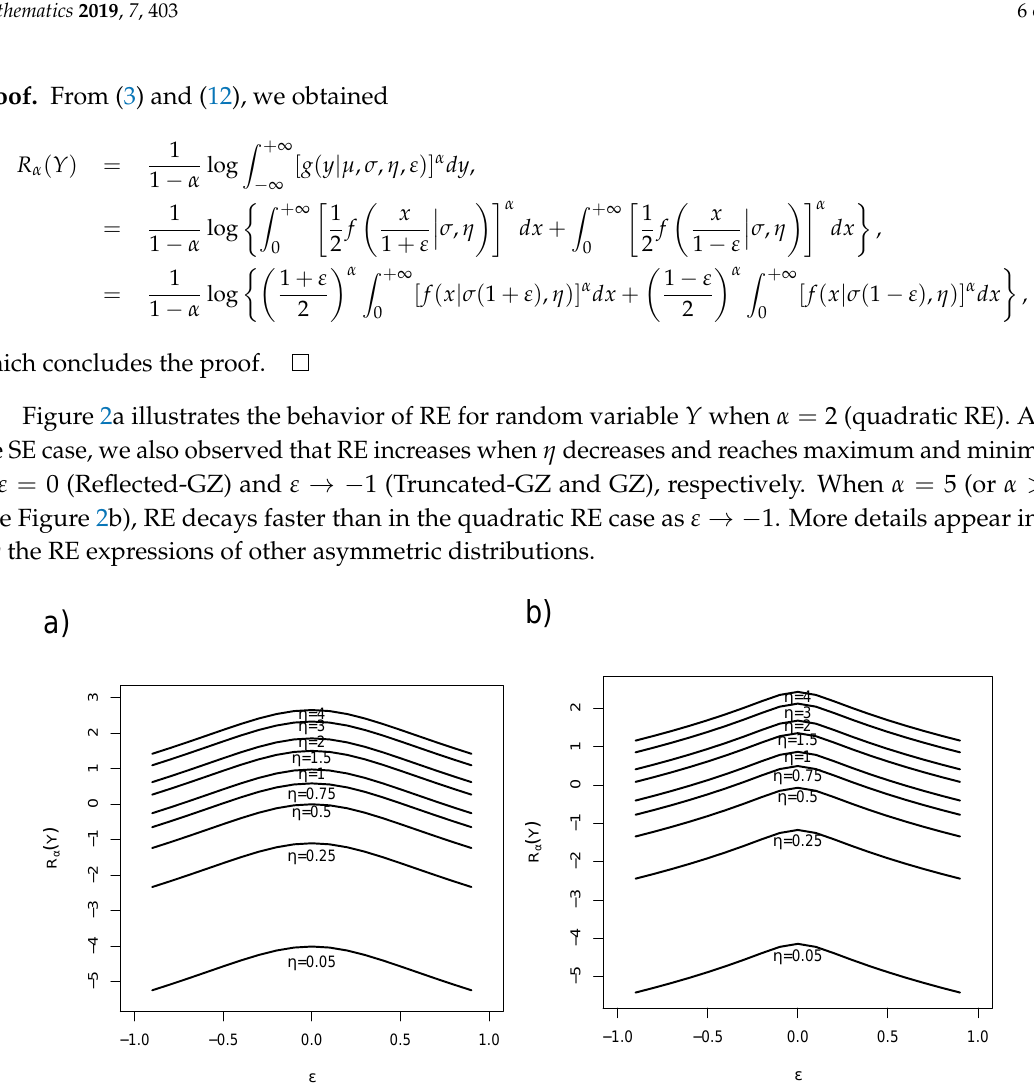
Figure 2. Rényi entropy of SRG distributions for σ = 1, − 1 < ε < 1, several values of η and ( a ) α = 2 and ( b ) α = 5